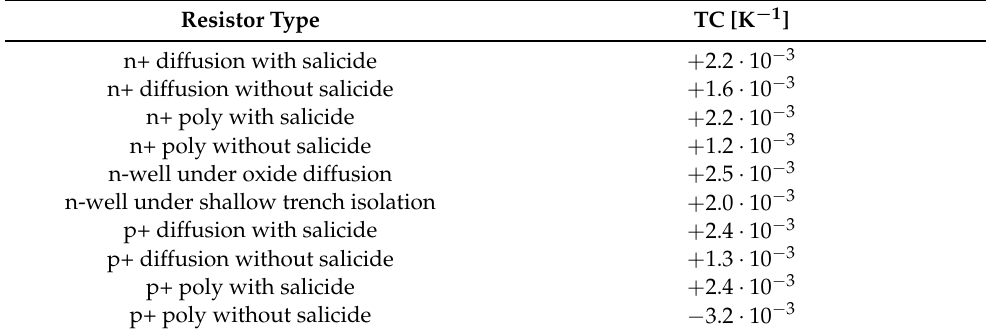
Table 2. First order TCs of different resistor types in a standard 65-nm CMOS process [68].